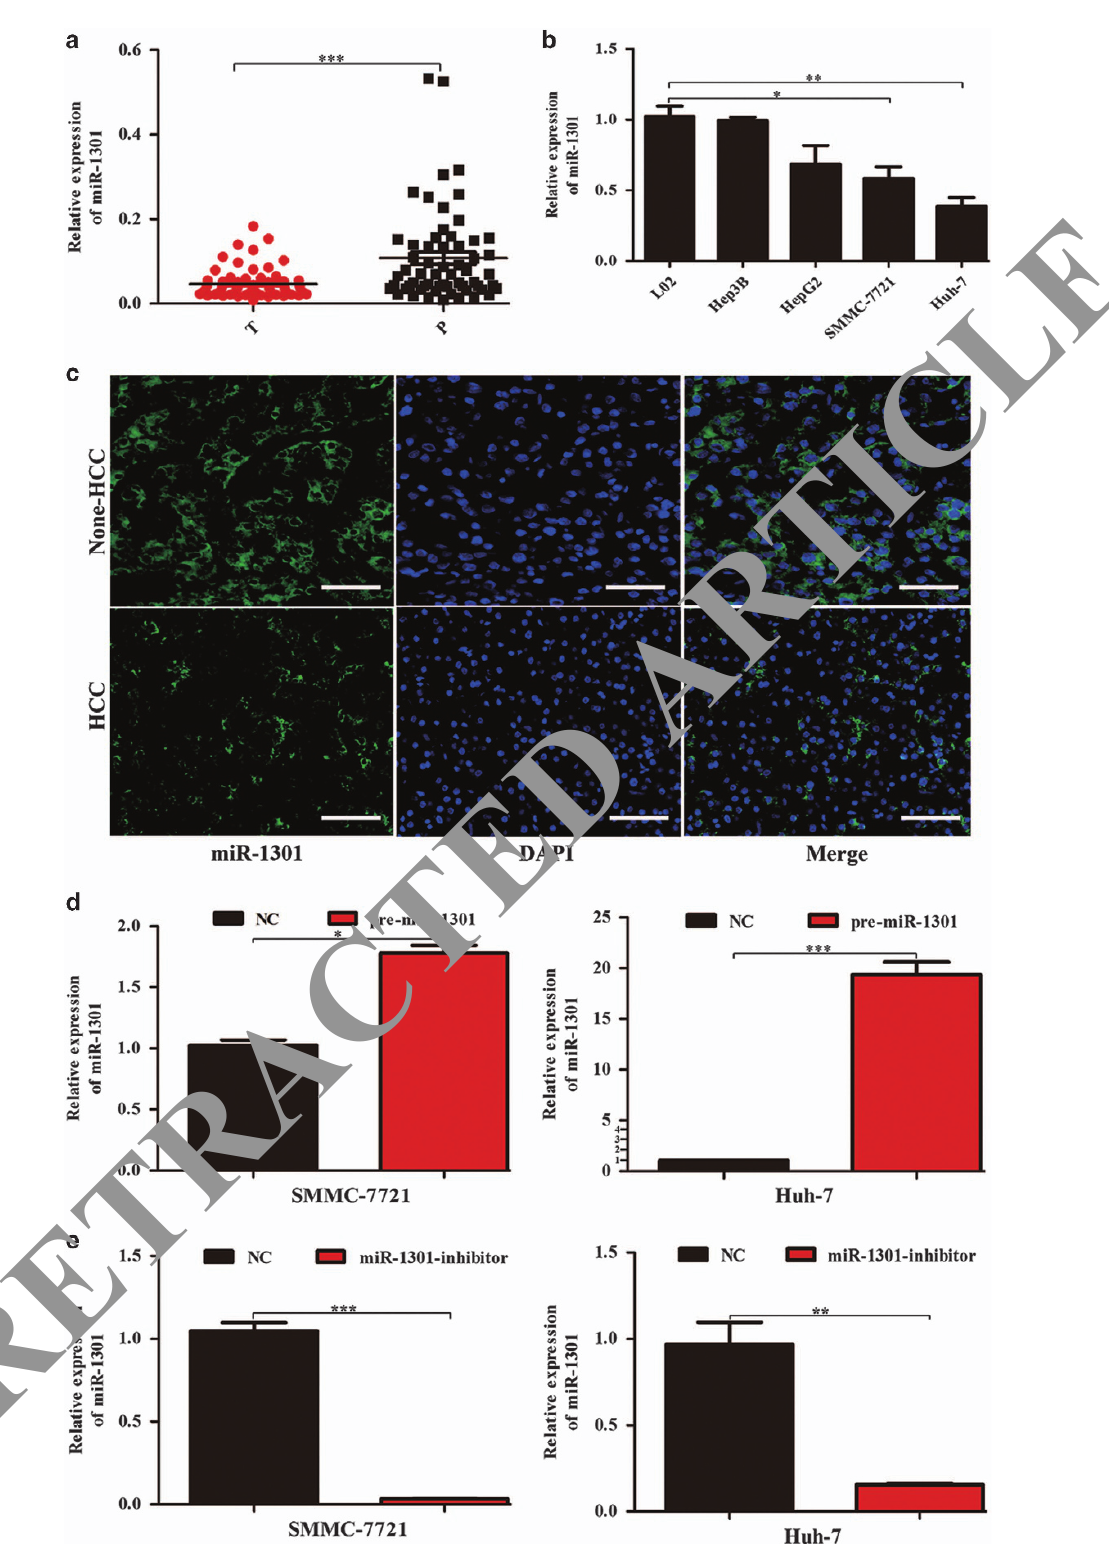
Figure 1 miR-1301 was downregulated in HCC tissues and cell lines.( a ) The levels of miR-1301 expression in 60-paired humanHCC and adjacent normal tissues byqPCR. ( b ) The levels of miR-1301 expression in HCC cell lines and normal L02 cells. ( c ) The expression of miR-1301 in HCC specimens and adjacent normal tissues was detected by FISH assay (scale bars, 50 μ m). ( d and e ) SMMC-7721 and Huh-7 cells were transfected with specific pre-miR-1301 or miR-1301 inhibitor, respectively. Cells transfected with emptylentiviral vectors served as a negative control (NC). miR-1301 expression was analyzed bymiRNART-PCR after transfection; cells transfected with empty lentiviral vectors were used as NC. * P o 0.05, ** P o 0.01, *** P o 0.001